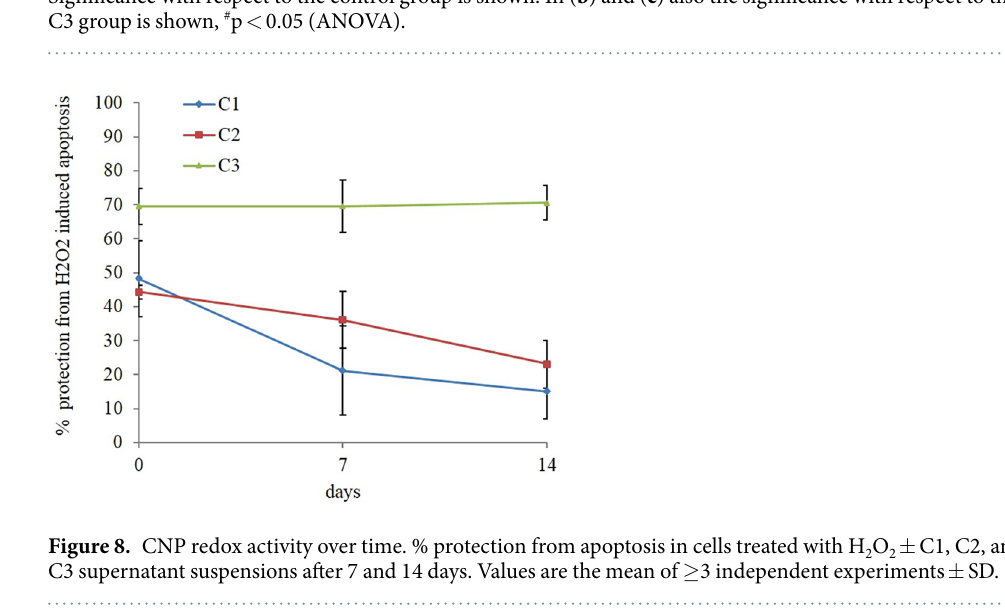
Figure 7. Redox active CNPs protect cells from hydrogen peroxide and UVB. ( a ) ROS levels increment measured by DHR fluorescent signal detected by flow cytometry 1 h after cell treatment with H 2 O 2 ± CNPs. ( b ) % of apoptosis detected 24 h after cell treatment with H 2 O 2 ± CNPs. ( c ) % of apoptosis detected 24 h after cell treatment with UVB ± CNPs. Values are the mean of ≥ 3 independent experiments ± SD; * p < 0.05 (ANOVA). Significance with respect to the control group is shown. In ( b ) and ( c ) also the significance with respect to the C3 group is shown, # p < 0.05 (ANOVA).